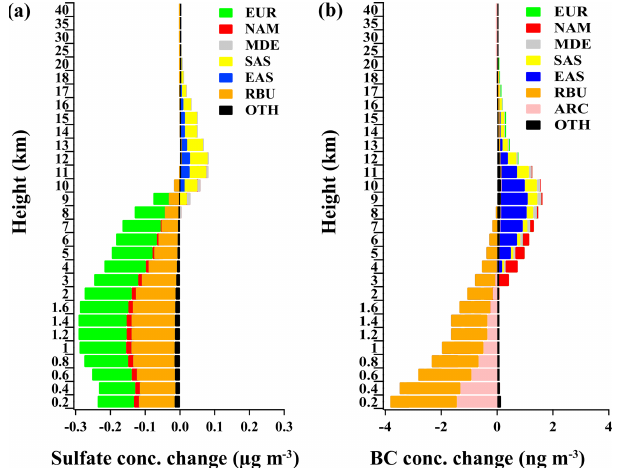
Figure 7. Changes in annual mean vertical profile of sulfate ( a ; µgm − 3 ) and BC ( b ; ngm − 3 ) concentrations over the Arctic con- tributed by the tagged source regions between 1980 and 1984 and 2014 and